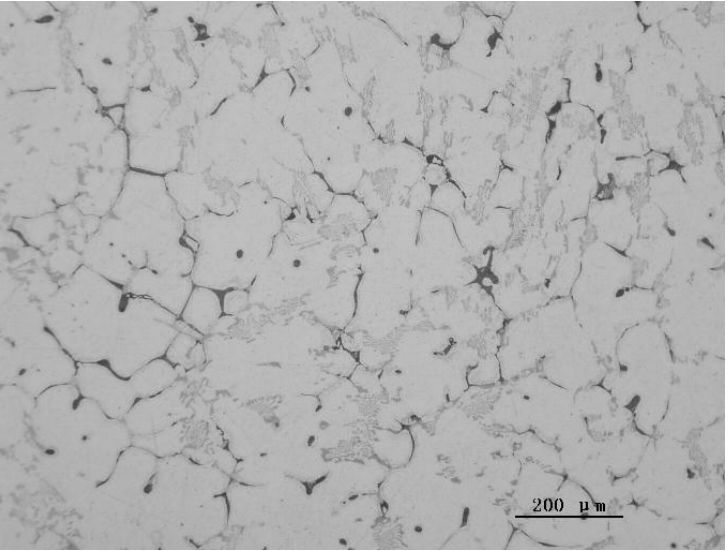
Figure 4. The as-cast microstructures of Sample